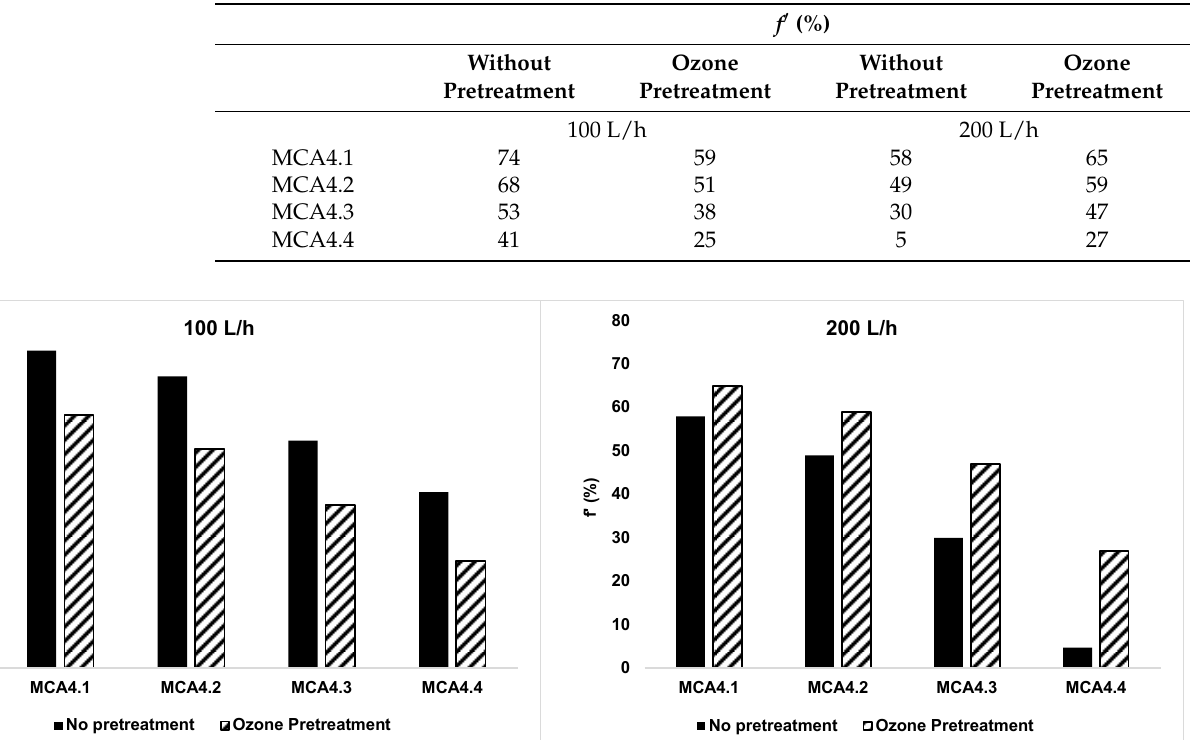
Table 4. Intrinsic rejection coefficient f (cid:48) for each membrane, feed flowrate, and with or without ozone pretreatment.